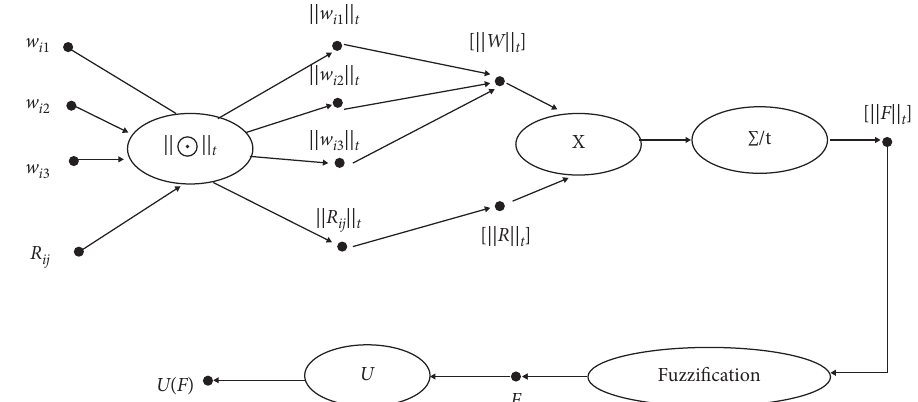
Figure 3: Computational network of FMCDM.